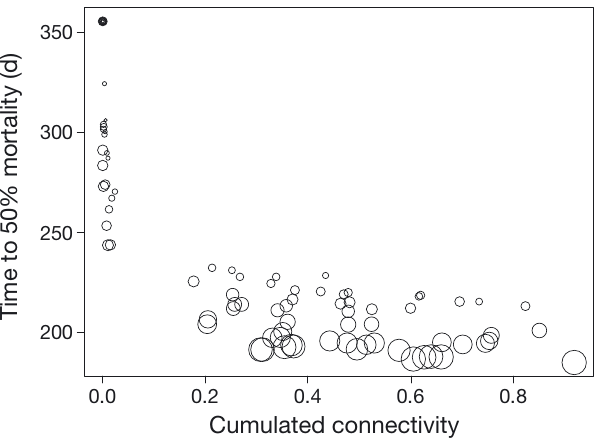
Fig. 6. Plot between the time to obtain 50% mortality in each patch and connectivity between each patch and the patch initially infected in the REF simulation. The size of the circle is proportional to the oyster density in the destination patch